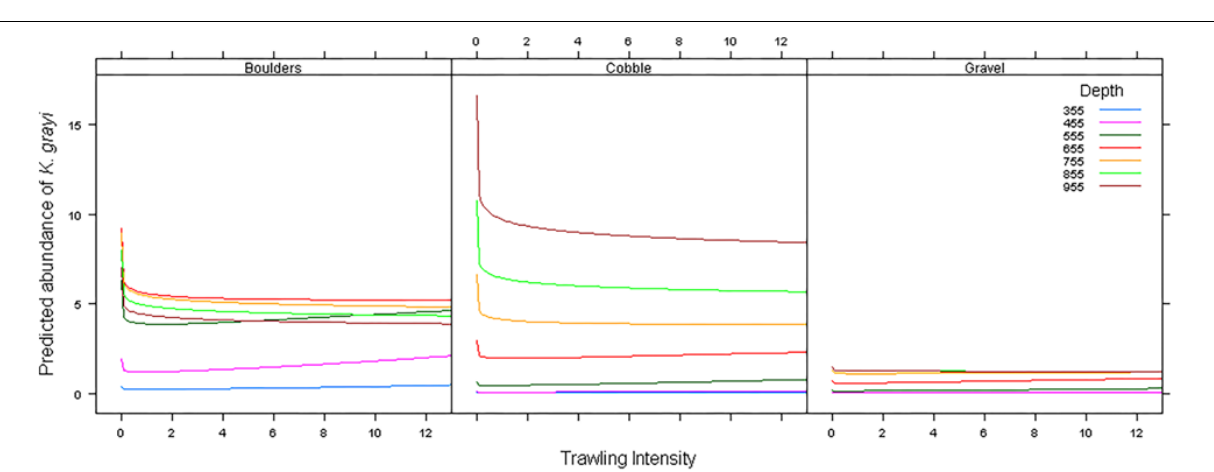
FIGURE 3 | Model predictions of the influence of trawling intensity on Keratoisis grayi counts in boulders, cobble, and gravel at various depths in Haddock Channel.